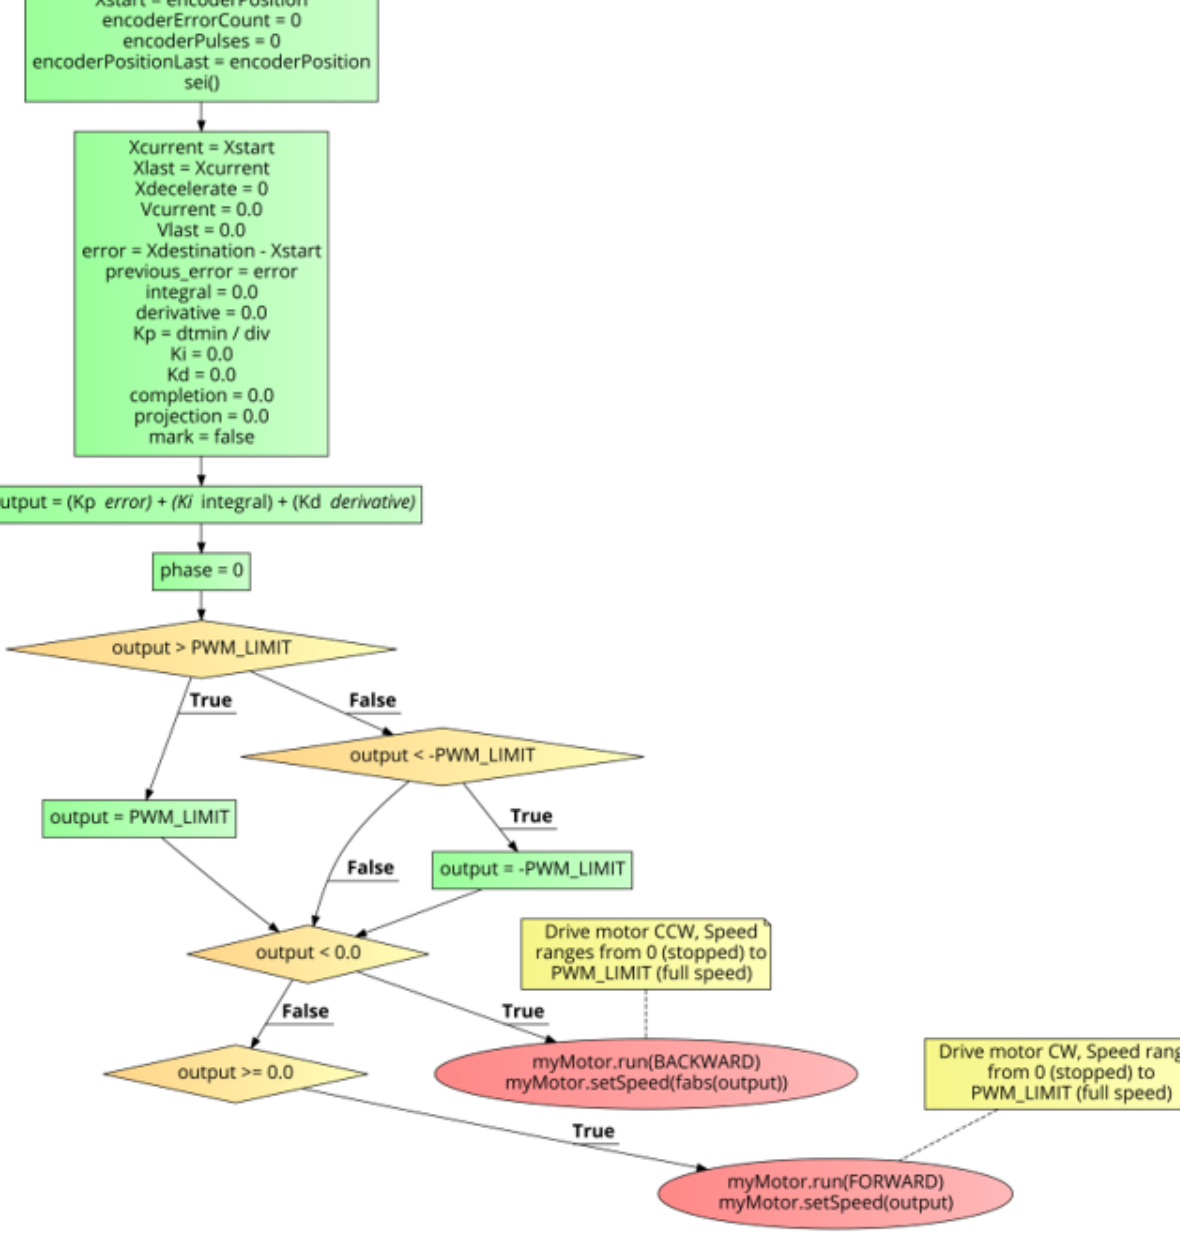
Figure 5. PID++ Flow Chart #0 - Initialization